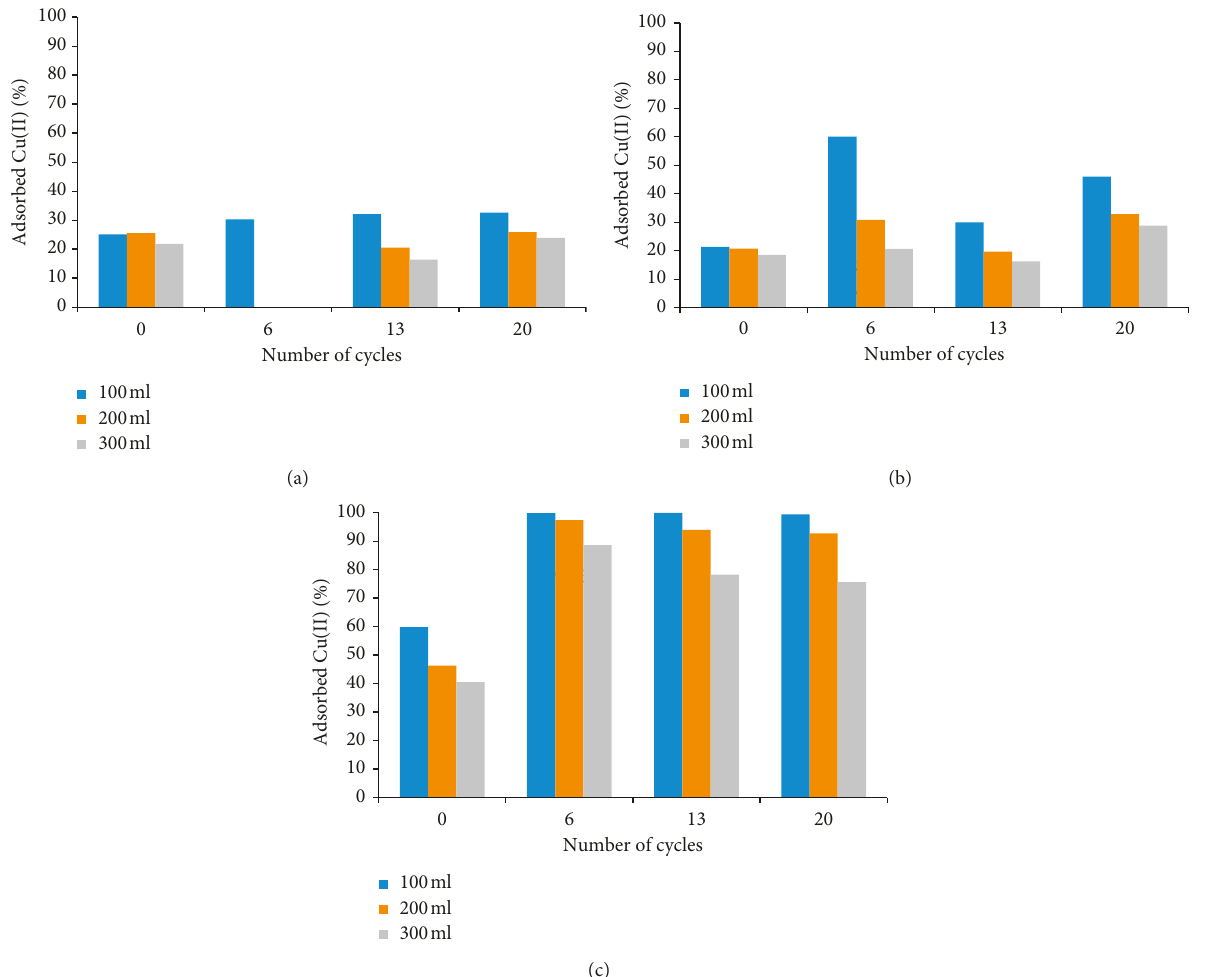
Figure 5: Adsorption (%) of Cu 2+ on Si c (a), Si c -[BAC-DMEDA] (b), and Si c -[BAC-EDDA] (c) at increasing adsorption-desorption